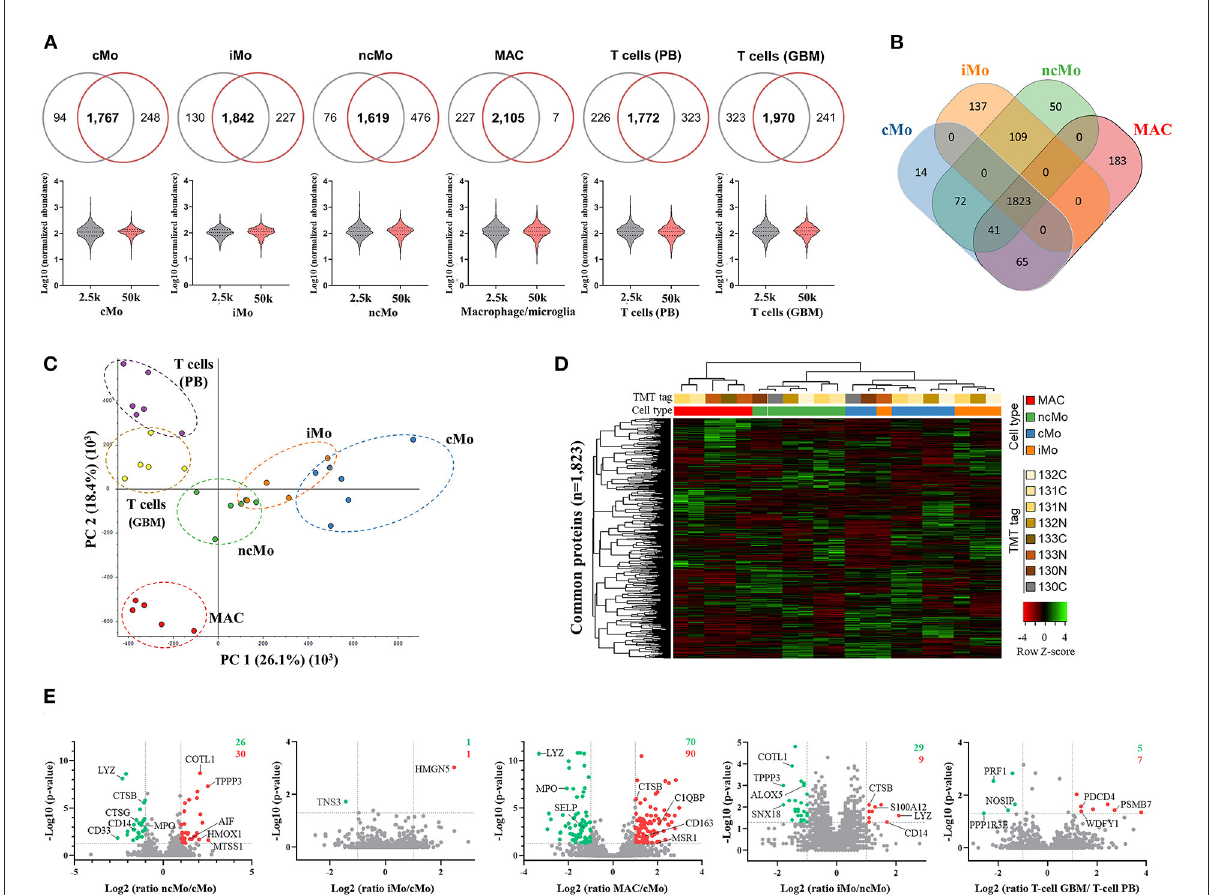
FIGURE4 Quantitative proteomics analysis of the three major monocytic populations from peripheral blood of healthy donors and macrophages/microglia from glioblastoma patients. (A) Proteins systematically identified and quantified in all biological replicates in 2.5k (grey) and 50k (dark pink) cells. Venn diagrams (upper figure) display the overlapped proteins between the evaluated cell numbers, whereas the violin plots (lower figure) show the distribution of the quantitative data. (B) Venn diagrams of proteins identified and quantified in all donors, indicating common and distinctive proteins per population. (C) Principal component analysis (PCA) plot displaying the clustering of sample populations based on abundances of all proteins identified and quantified ( n = 3,455) with at least two unique peptides and 1% FDR. (D) Hierarchical clustering analysis (using Pearson’s correlation distance/complete linkage method) and heatmap comparing Z-scores from normalized expression values of proteins commonly expressed by monocytic populations (major populations and MAC). (E) Volcano plots showing log2 ratios of measured proteins in ncMo, iMo and MAC vs. cMo, iMo vs. ncMo, and T cells from GBM vs. T cells from PB. Green dots correspond to significantly ( p -value < 0.05) downregulated proteins (ratio < 0.5), whereas red dots represent significantly upregulated proteins (ratio > 2). Numbers in the upper-right corner depict the total number of up- (red) and down-(green) regulated proteins per plot. cMo, classical monocytes; iMo, intermediate monocytes; ncMo, non-classical monocytes; MAC , macrophage/microglia; GBM , glioblastoma; PB, peripheral